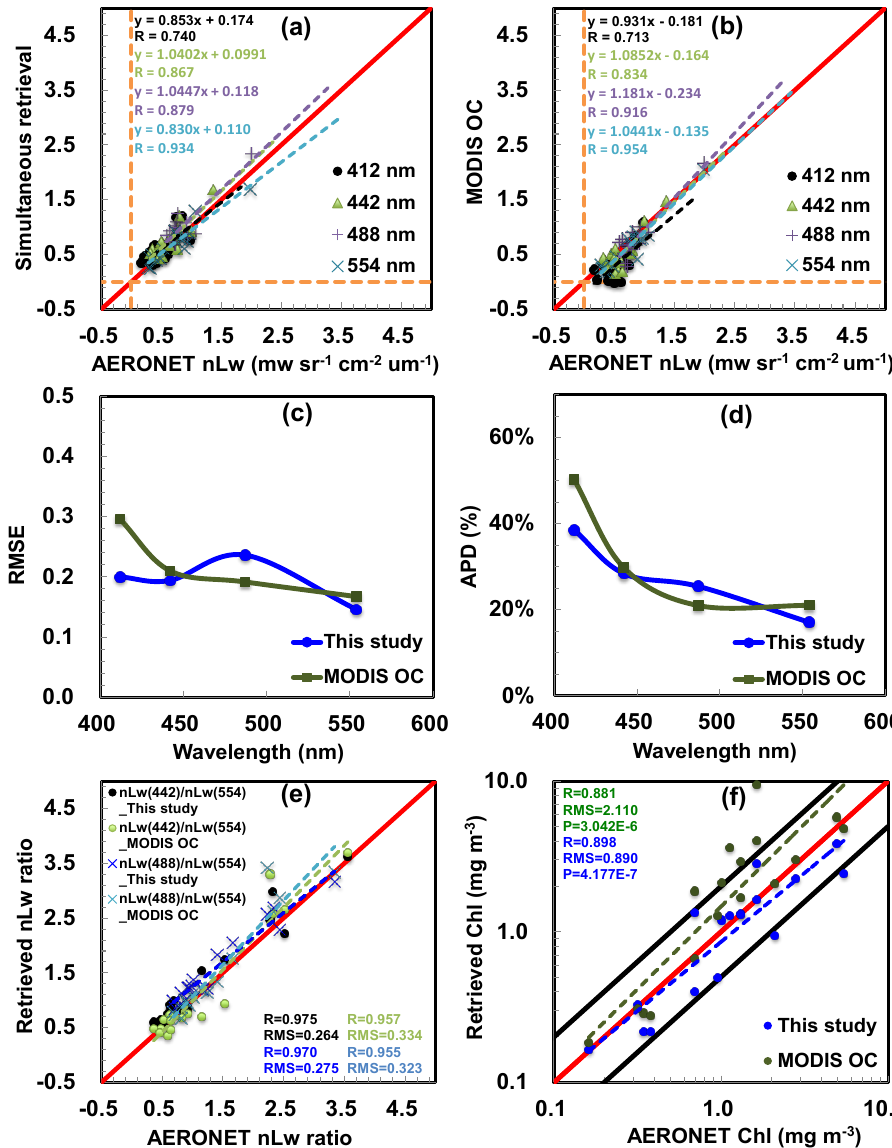
Figure 11. Similar to Fig. 7 but using the satellite measurements covered in